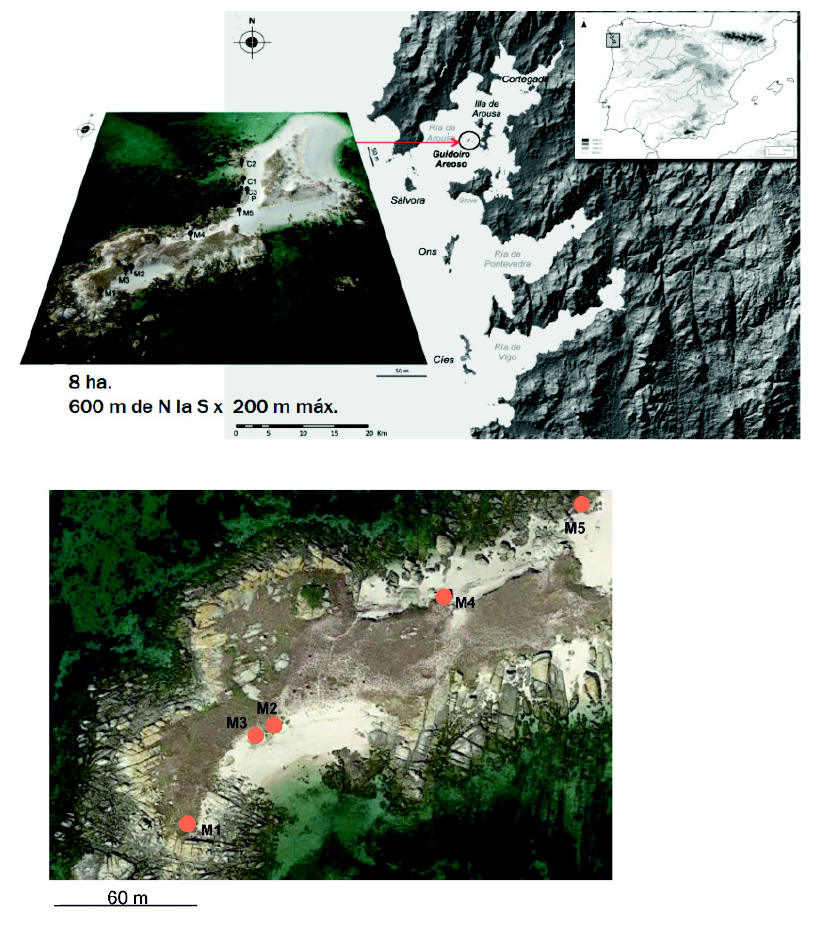
Figure 1. Location of the Guidoiro Areoso islet in the Ría de Arousa (modified after [32]).